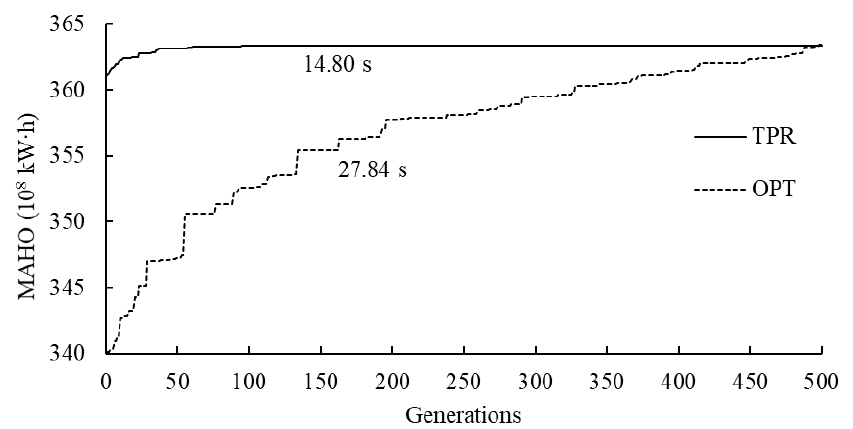
Figure 6. Optimization processes of MAHO of UYR multireservoir system based on the OPT approach and the TPR rules in the ninth calculation.